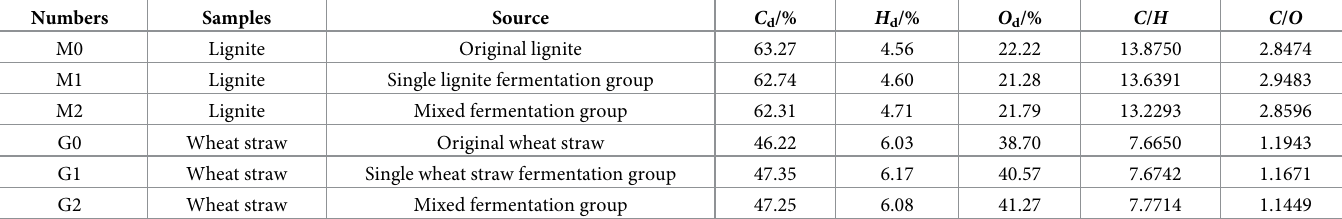
Table 4. Changes of element content before and after degradation of lignite and